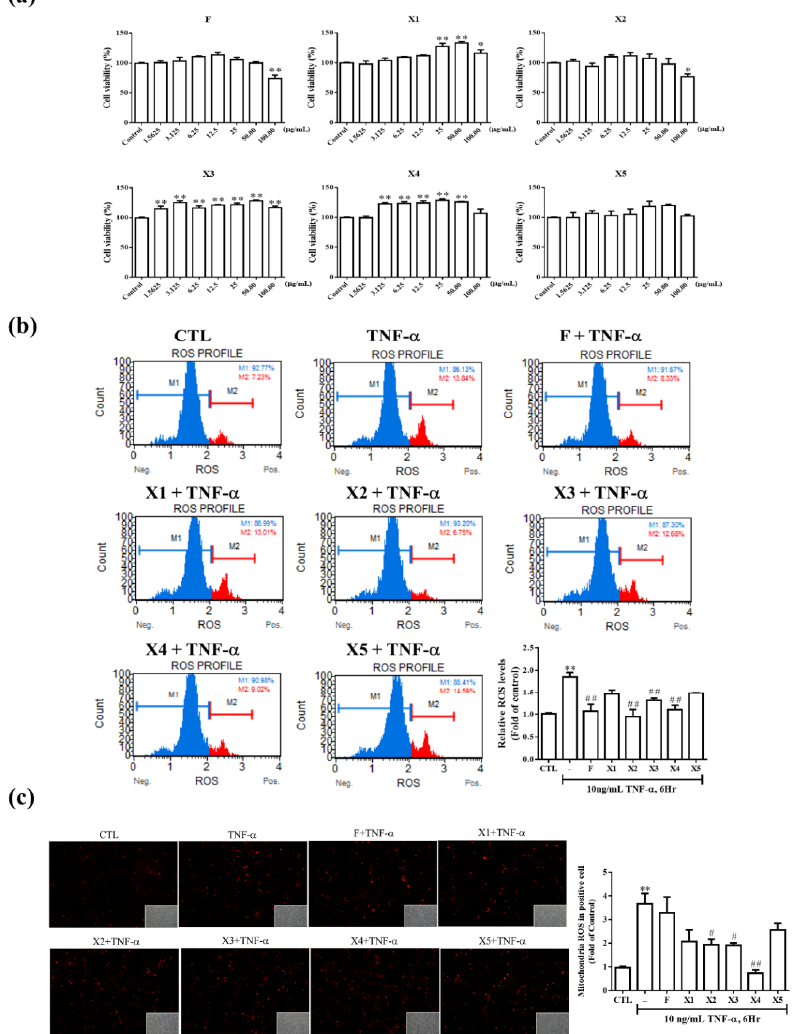
Figure 3. The antioxidant e ff ect of ferrocene-1 H -1,2,3-triazole hybrids in RMCs. E ff ect of ferrocene- 1 H -1,2,3-triazole hybrids on cell viability. ( a ) RMCs were treated with twofold serial dilutions of ferrocene-1 H -1,2,3-triazole hybrids for 24 h, and cell viability was determined by the MTT assay. Data are expressed as % of control (1% dimethyl sulfoxide (DMSO)-treated group) and each column represented the mean ± standard error of the mean (SEM) of four independent tests. ( b , c ) Intercellular ROS in RMCs treated with F , X1 , X2 , X3 , X4 , or X5 at 12.5 µ g / mL for 2 h at 6 h post-TNF- α (10 ng / mL) incubation were assessed using DHE fluorescence followed by flow cytometric analysis ( b ), and MitoSOX staining (mitochondrial staining) followed by immunofluorescence. Results are expressed as mean ± SEM of at least three repeated and independent assays, * p < 0.05; ** p < 0.01 versus control; # p < 0.01; ## p < 0.01 versus TNF- α treatment